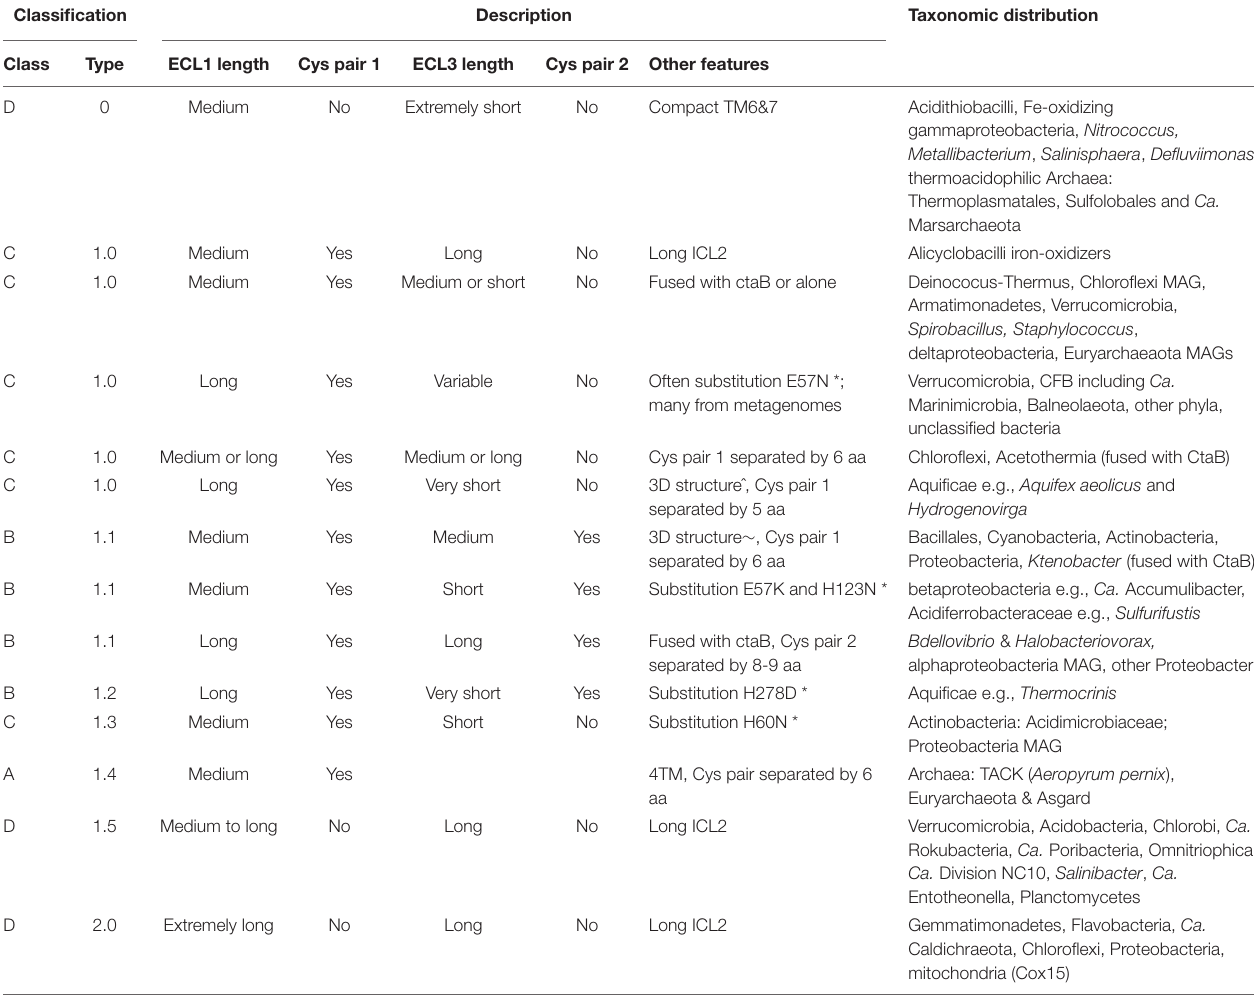
TABLE 1 | Classification of heme A synthase